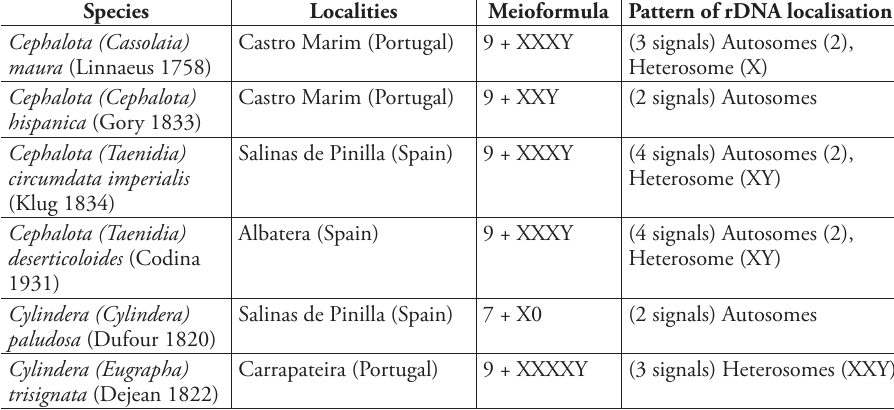
table 1. Localities, male meioformula and pattern of rDNA localization for sampled species of tiger beetles.